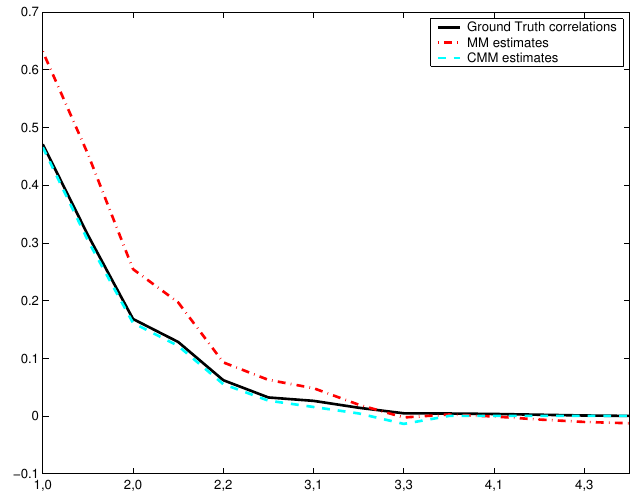
Figure 6 – Mean correlation measures under the weak dependency case for the classical (MM) and the corrected (CMM) Method-of-Moments